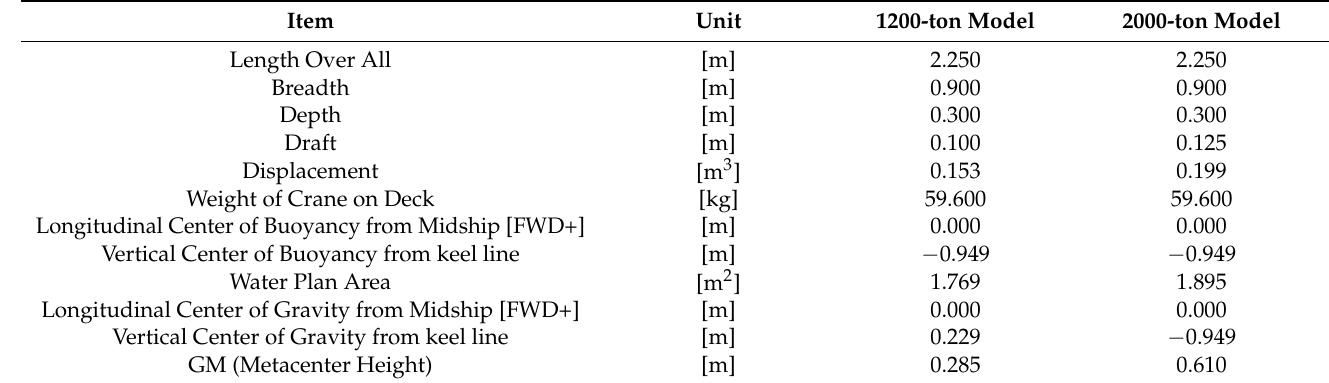
Figure 14. Ocean engineering basin of the Korea Research Institute of Ships and Ocean Engineering (KRISO). Table 2. Specification of crane model.